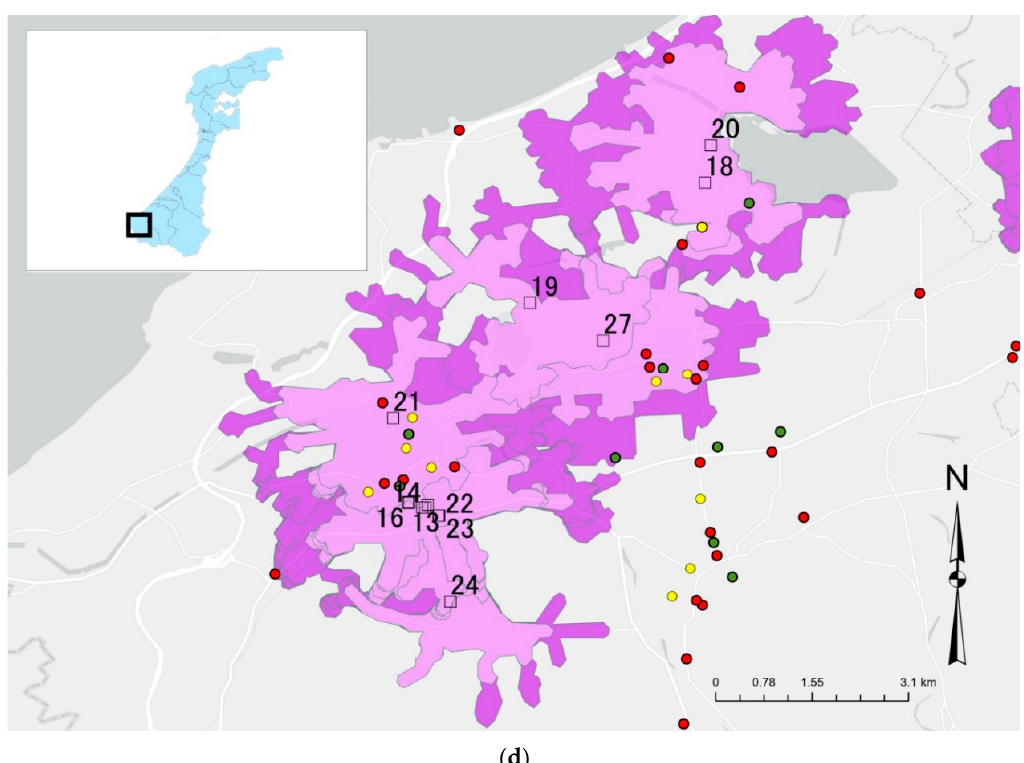
Figure 6. ( a ) Geographical distribution of GHs and SPs in ELAs in Komatsu City. ( b ) Geographical distribution of GHs and SPs in ELAs in Kawakita Town (For legends, see Figure 6a). ( c ) Geographical distribution of GHs and SPs in ELAs in Nomi City (For legends, see Figure 6a). ( d ) Geographical distribution of GHs and SPs in ELAs in Kaga City (For legends, see Figure 6a).